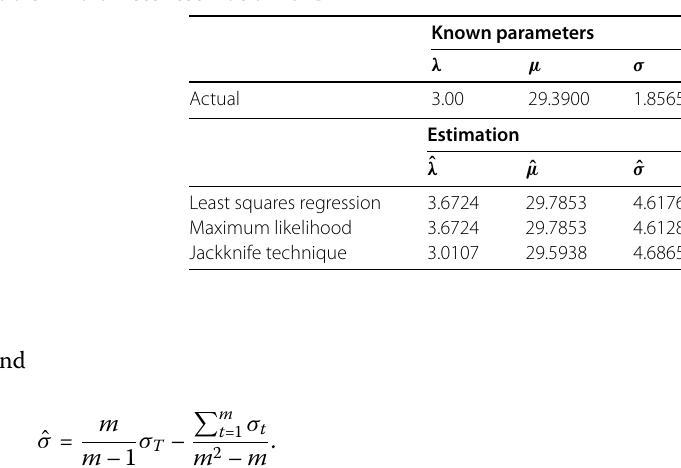
Table 2 Parameter estimation for